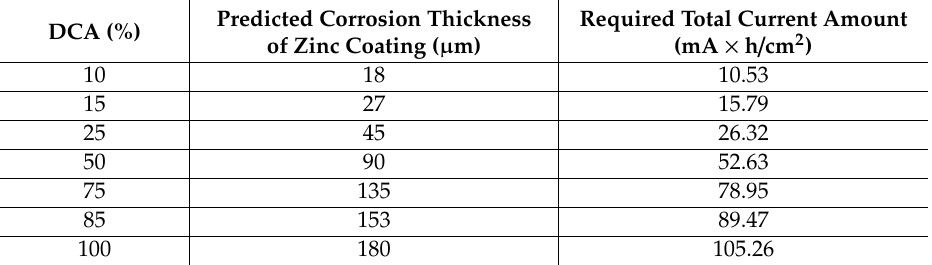
Table 2. The relationship among DCA, zinc coating thickness and the total current amount.